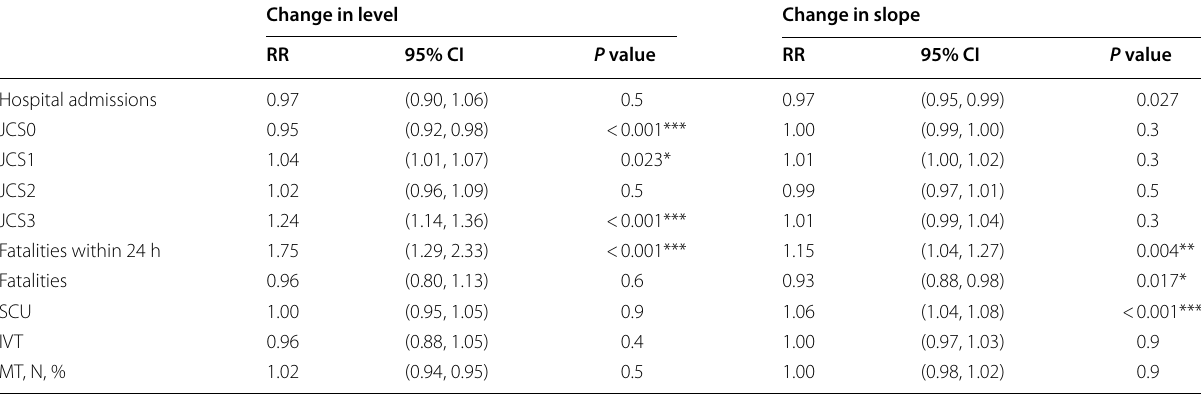
Table 3 Interrupted time series analysis for the number of patients with stroke from April 2018 ″ to 31 August